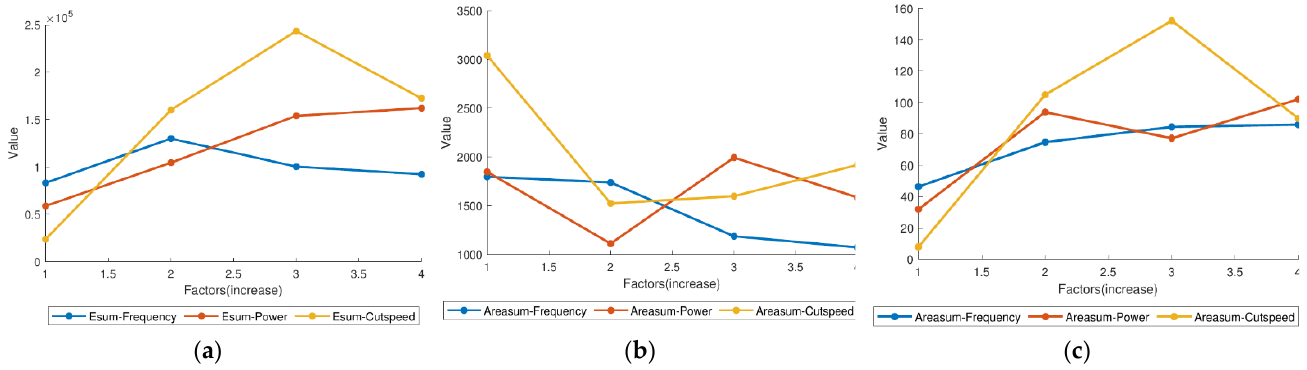
Figure 12. ( a ) Total energy of different factors; ( b ) total area of different factors; ( c ) total ESR of different factors.